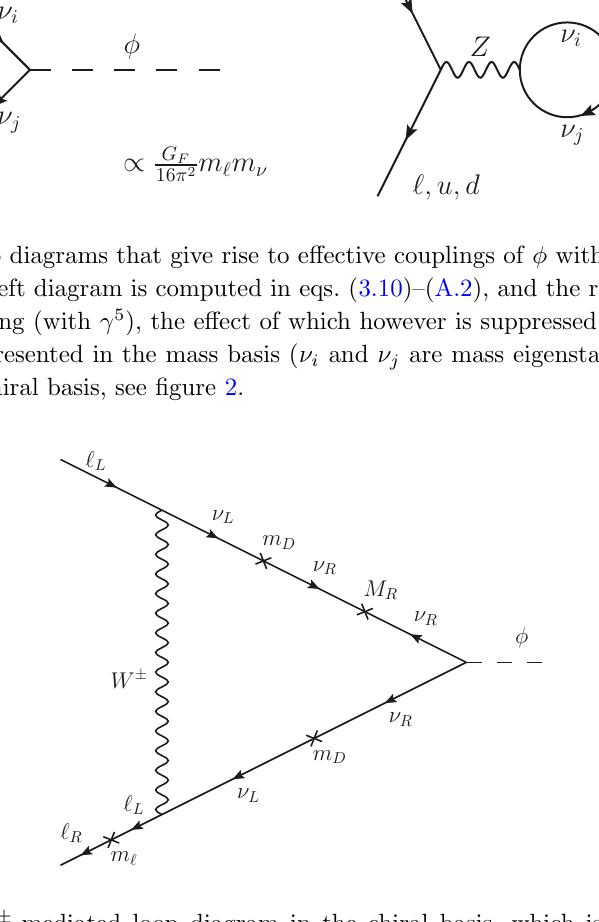
Figure 2 . The W (cid:6) -mediated loop diagram in the chiral basis, which is equivalent to the left diagram in (cid:12)gure 1 in the mass basis. It shows explicitly how chirality changes in the process. Since in the chiral basis W (cid:6) only couples to left-handed leptons and (cid:30) only to (cid:23) R , we need two mass insertions of m D to connect (cid:23) L and (cid:23) R . Other two mass insertions, M R and m ‘ , are also necessary due to additional requirements | see discussions in the